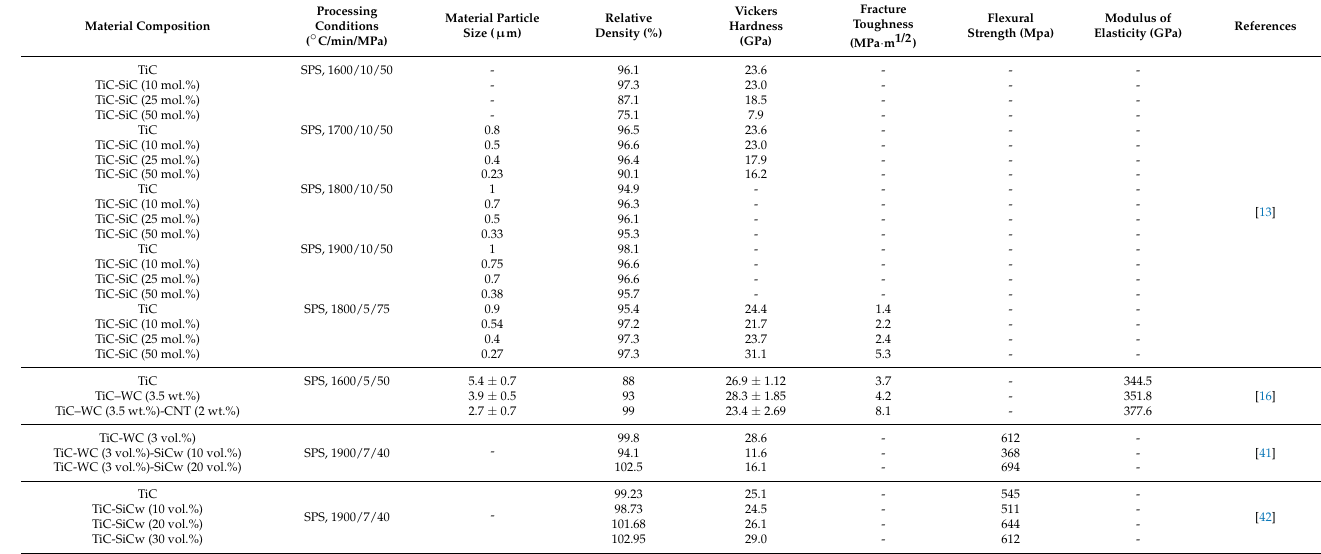
Table 2. Effects of preparation process and carbide type on mechanical properties of TiC-based composites.